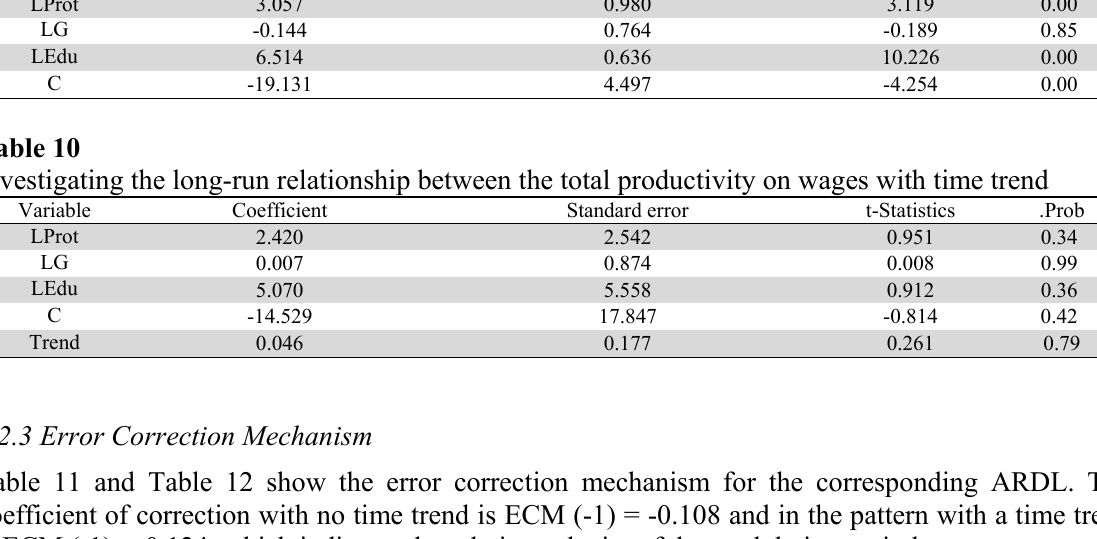
Variable Coefficient